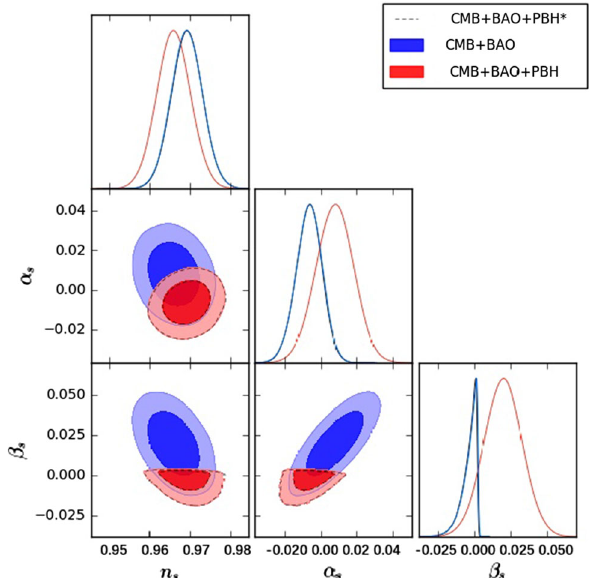
Fig. 1 The contour plots and the likelihood distributions for n s , α s , β s at the 68% and 95% CL by using CMB + BAO + PBH*, CMB + BAO and CMB + BAO + PBH,